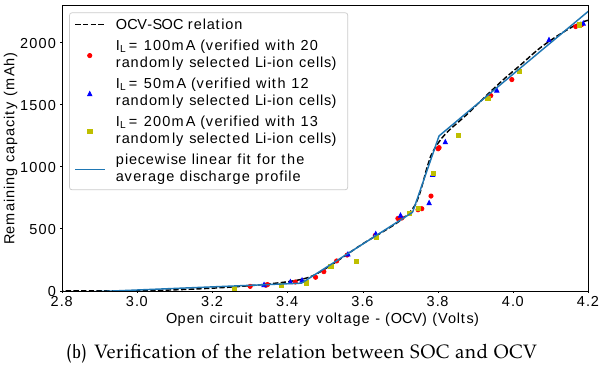
Figure 18. Relation between battery voltage and remaining